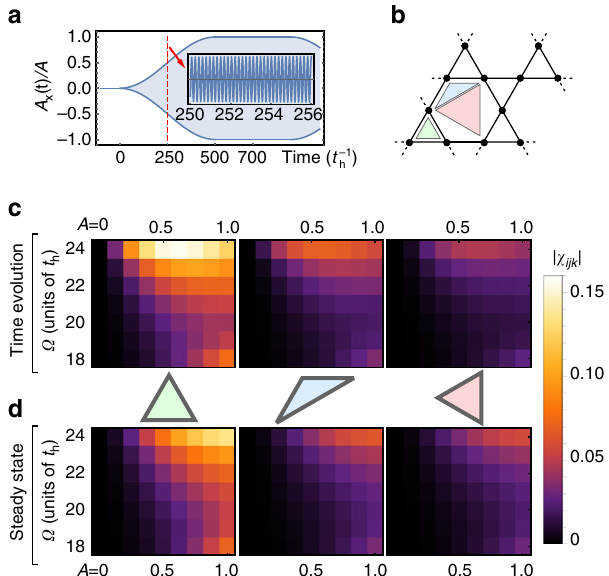
Fig. 4 Time evolution for broad-pulse irradiation. Comparison of the Floquet chiral spin model (Eq. (3)) and the exact time evolution of the 12-site U = 30 Kagome Hubbard model (Eq. (1)) driven by circularly polarized light with ultra-slow adiabatic pump envelopes a . The scalar spin chiralities χ ijk ¼ (cid:12) (cid:11) on elementary triangles of the unit cell b are depicted in c , d . S i (cid:3) S j ´ S k ð Þ c depicts χ ijk ( t ) measured from exact time evolution and averaged over the pump plateau; d depicts corresponding static expectation values of the Floquet spin model with Heisenberg and chiral couplings chosen as a function of A , spin dynamics described by Eq. (3) and barely absorbs energy on below.